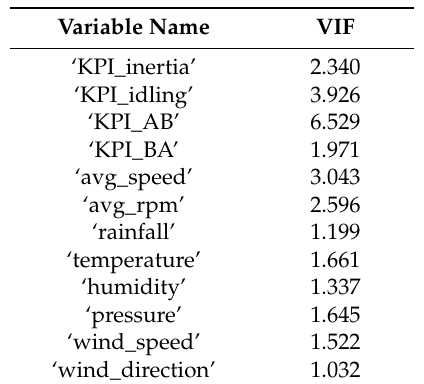
Table 4. VIF for the selected predictor